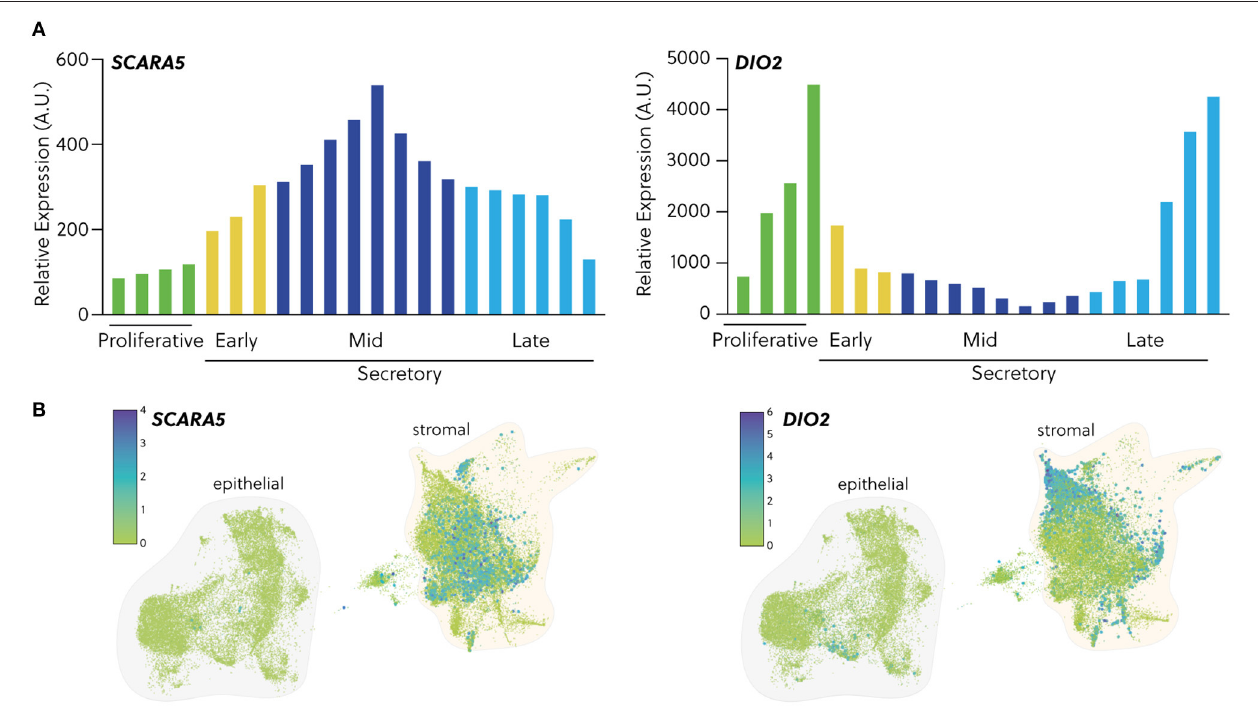
FIGURE 3 | Expression of cell fate biomarkers. (A) In silico analysis of GDS2052 microarray data showing transcript expression of the DeC biomarker SCARA5 and the senDeC biomarker DIO2 in proliferative, early-, mid- and late-secretory endometrium expressed in arbitrary units. (B) Temporal expression of SCARA5 and DIO2 transcripts in human endometrium from single cell profiling of endometrial biopsies obtained across the cycle ( n = 15). Data were extracted from Garcia-Alonso et al. (148) and available on